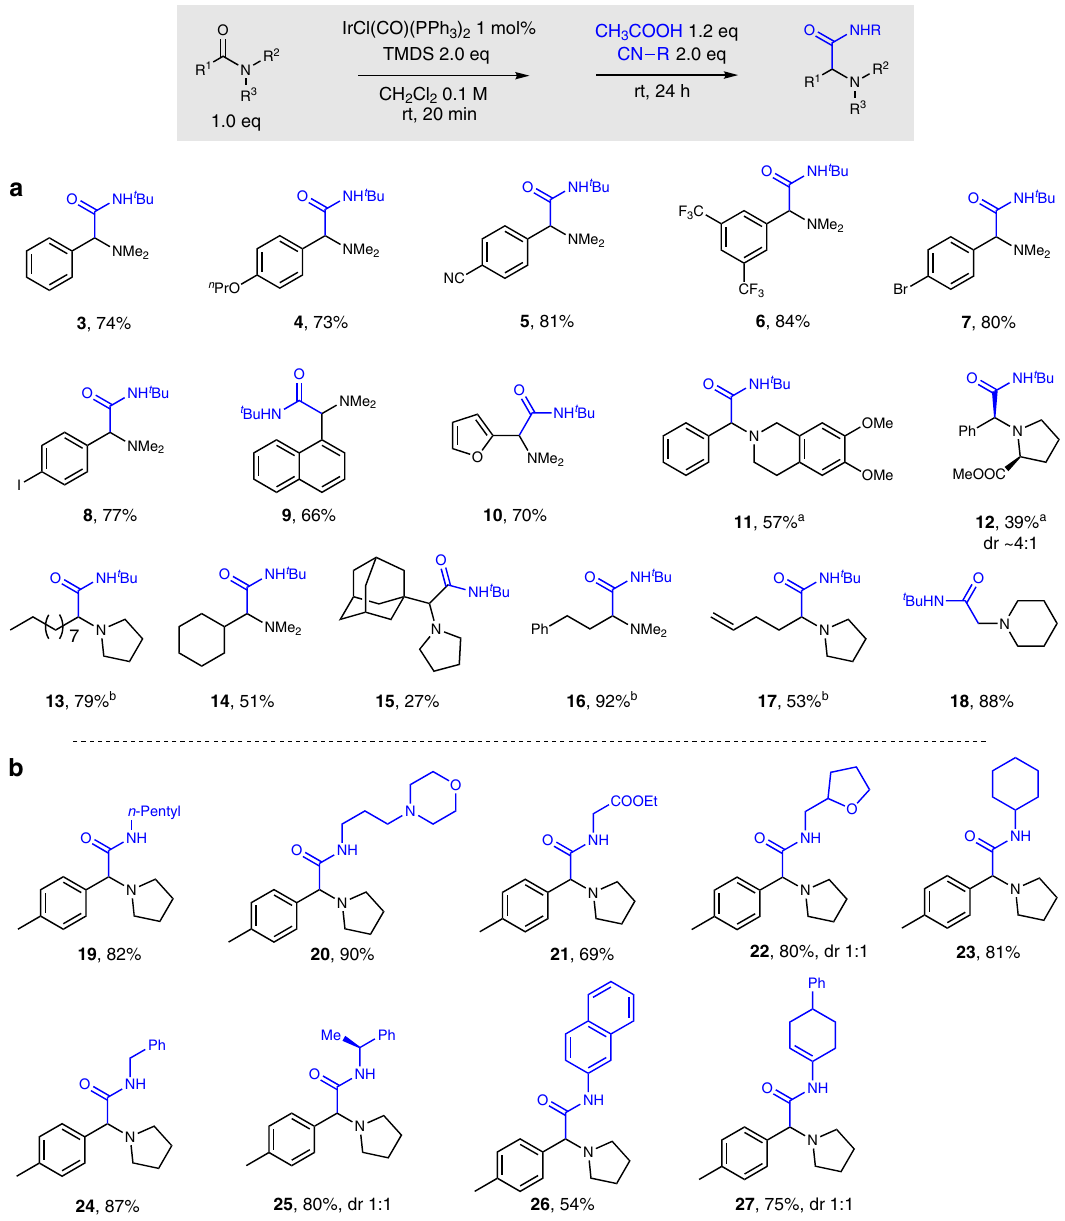
Fig. 2 Synthesis of α -amino amides. a Scope with respect to the tertiary amide. b Scope with respect to the isocyanide. Standard condition: amide 0.3 mmol, IrCl(CO)(PPh 3 ) 2 1 mol%, TMDS 0.6 mmol, CH 2 Cl 2 3 mL, isocyanide 0.6 mmol, CH 3 COOH 0.36 mmol; yields of puri fi ed product following fl ash column chromatography; a reaction was performed at 50 °C after the addition of tert -butyl isocyanide and CH 3 COOH; b with 0.9 mmol CH 3